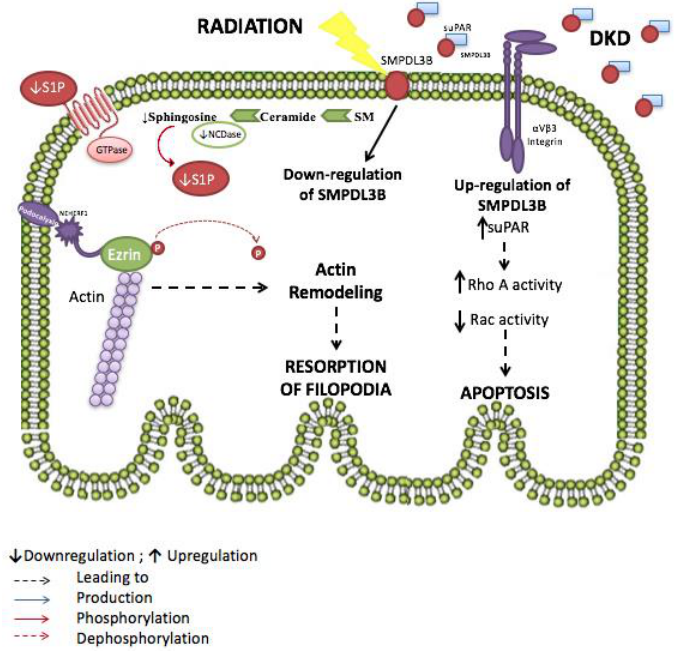
Figure 2. Proposed role for sphingomyelinase phosphodiesterase acid-like 3b (SMPDL3b) in